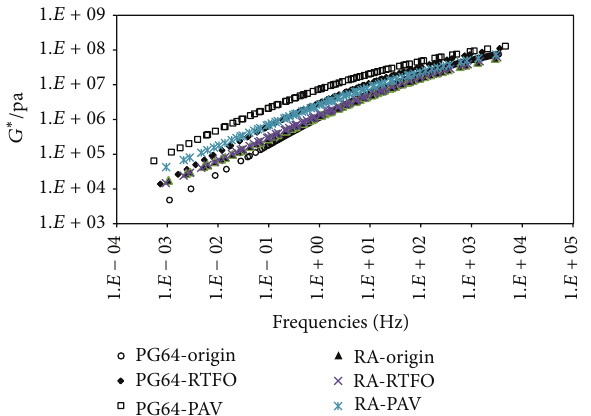
Figure 1: Master curves of 𝐺 ∗ for two kinds of asphalt at 20 ∘ C.